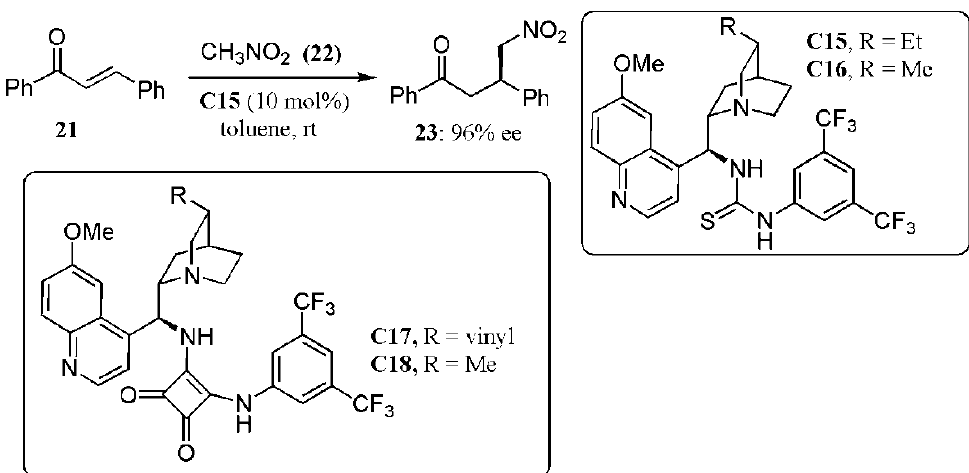
Figure 18. Cinchona-thiourea-catalyzed asymmetric Michael addition of chalcone to enones and the possible activation modes [47].